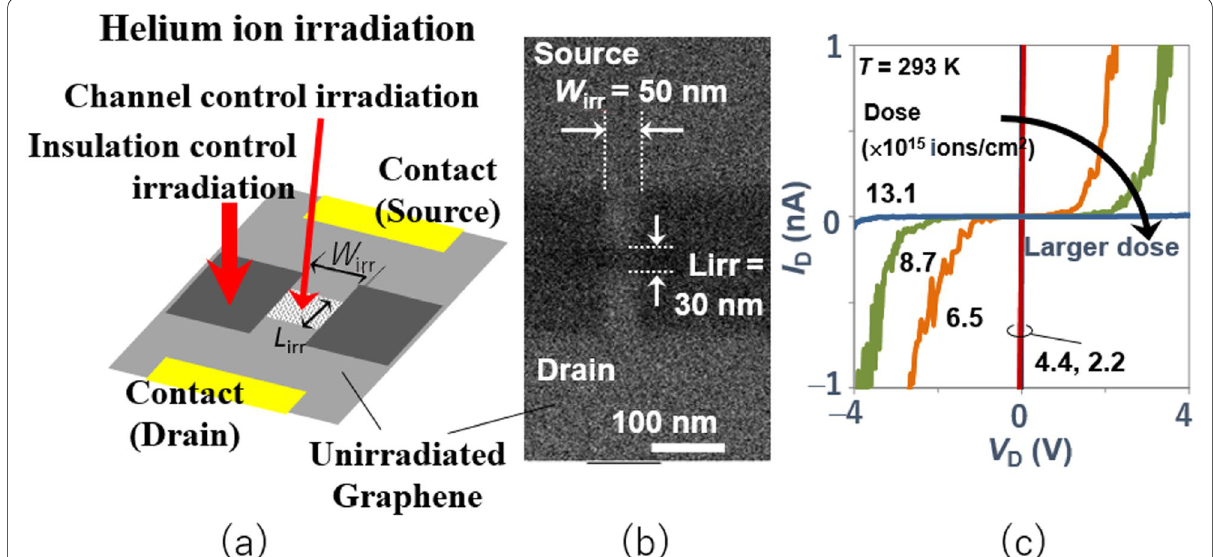
Fig. 7 Assessment of the effect of helium ion dose on the current-voltage characteristics of a single layer of graphene. a A schematic diagram of the test device, b a HIM image, and c a current-voltage plot. These data indicate that the graphene was transformed from the metal to the insulator by ion irradiation. Figure modified from